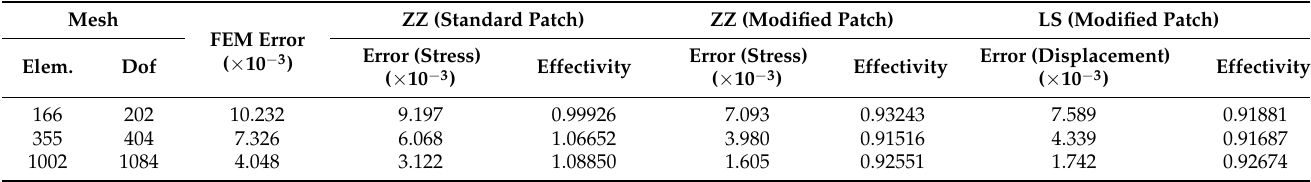
Table 8. Solution error and global effectivity for the plate with an opening problem using stress/displacement recovery and patch configuration (quadratic triangular element).